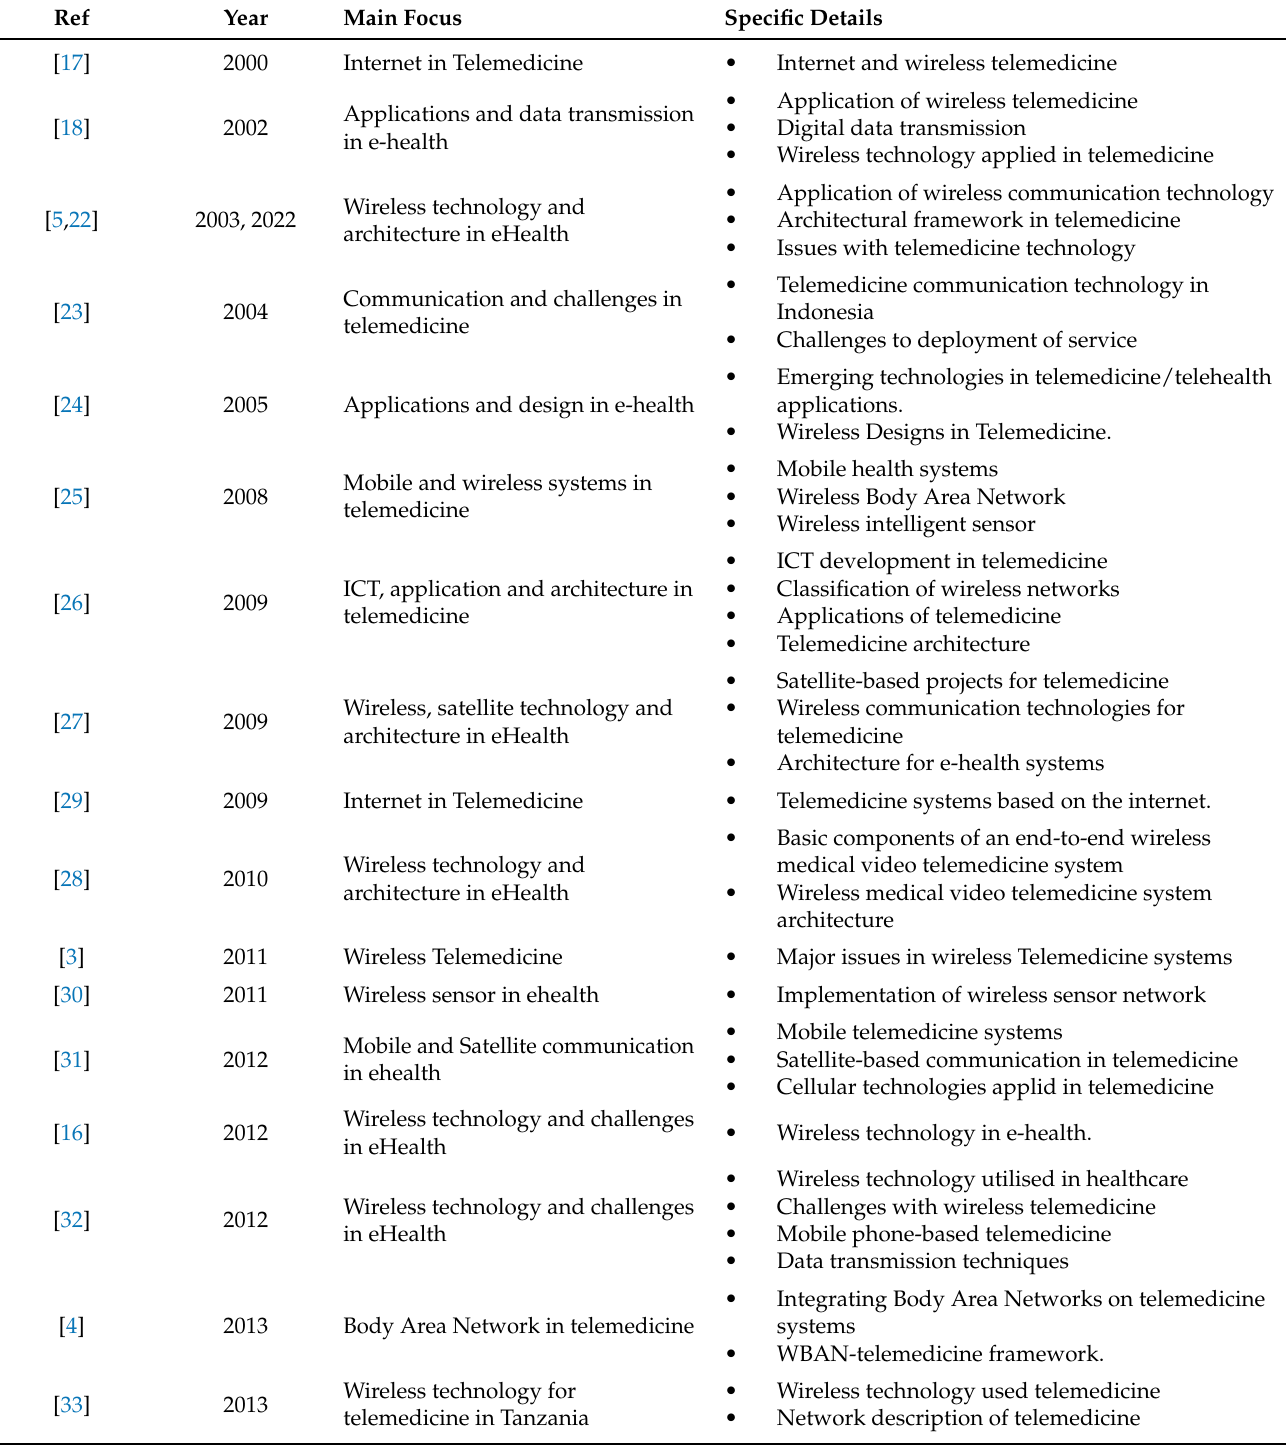
Table 1. Summary of Related